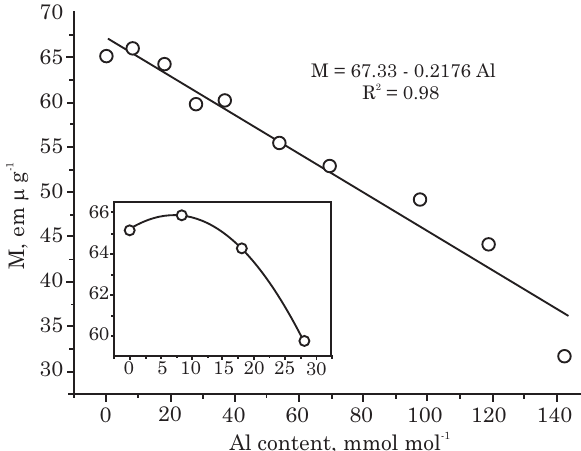
Figure 6. Magnetization at 10 kOe as function of isomorphic substitution of Fe 3+ for Al 3+ in synthetic substituted